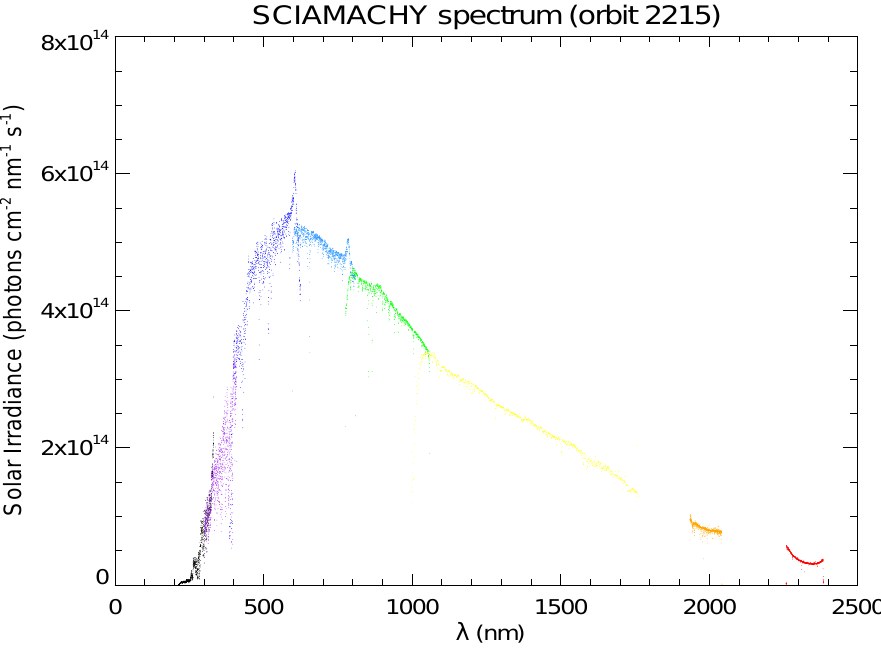
Figure 1. Solar spectrum measured by SCIAMACHY on 2 August 2002. The different colors represent its different channels from 1 to